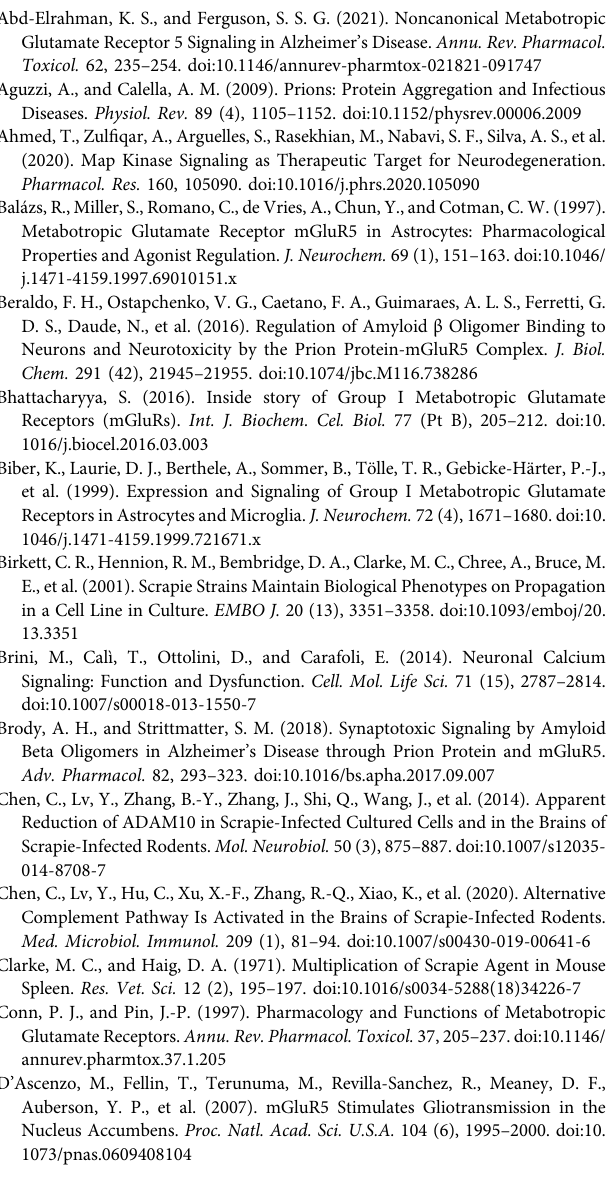
images of DAPI (blue), mGluR1 (green) and merge are indicated above. The IOD analysis for the signals of mGluR1 in the images of cortex, cerebellum and hippocampus sections are indicated on the right. Supplementary Figure S3 | The level of mGluR5 in brain tissues of 3 weeks and 12 weeks old healthy hamsters. Left : Western blot for the levels of mGluR5 in brains of two age groups. Relative molecular weights are marked on the left. Right : Densitometric analyses of the average gray values of the signals of the mGluR5 after being equilibrated with that of β -actin. Supplementary Figure S4 | Double-staining of mGluR1 with NeuN in cortex, cerebellum and hippocampus slices of 263K-infected hamsters at end stage. The images of DAPI, NeuN, mGluR5 and merge are indicated on the top. The magni fi cation views are shown on the right each